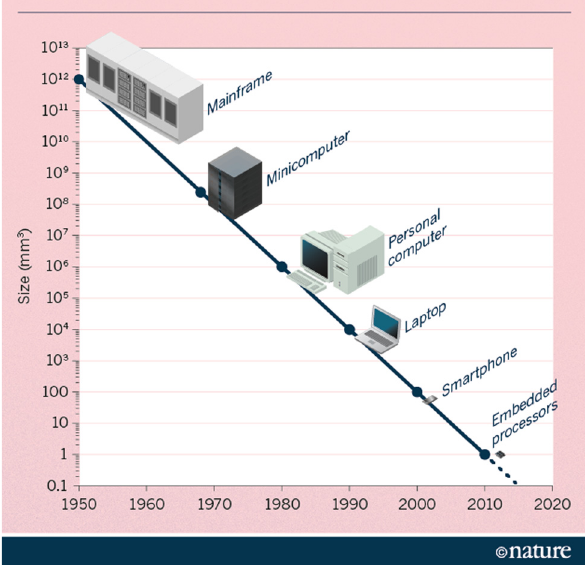
Figure 7: Evolution of microchip size [ 146,147 ]